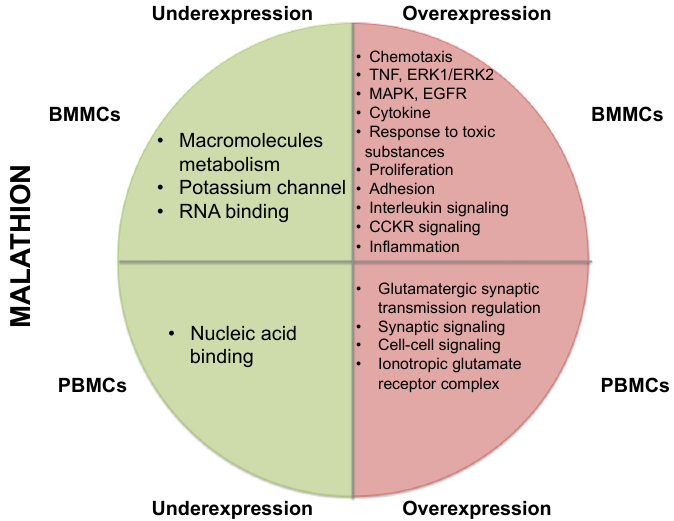
Figure 2. Summary of over ‐ representation test results of genes with altered expression in BMMCs and PBMCs exposed to malathion. Green section shows cellular functions associated with genes with underexpression, and red section with genes with overexpression. The upper part displays results of BMMCs and lower part shows results of PBMCs.